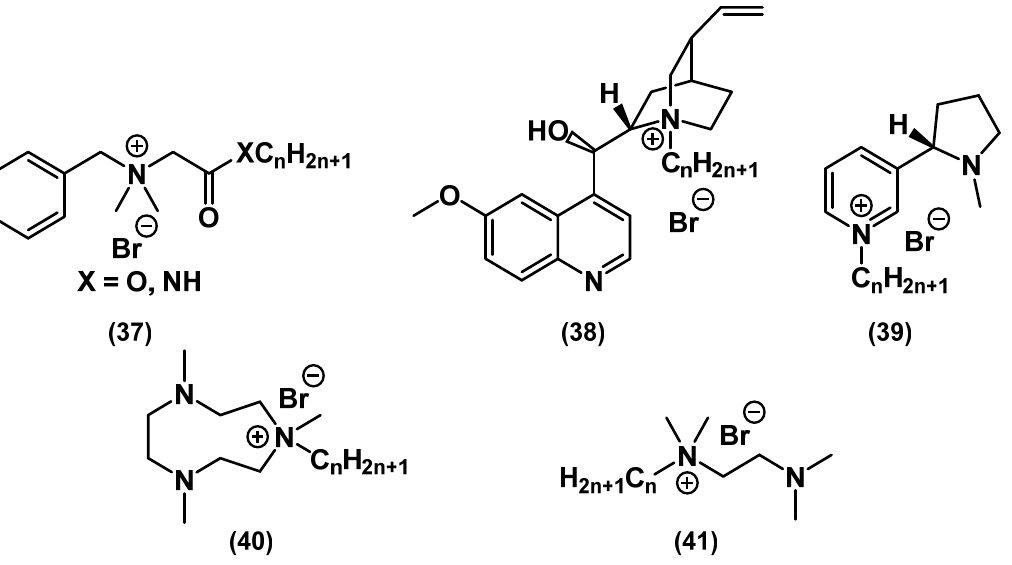
Figure 17. Mono-QACs from Wuest’s and Minbiole’s works.